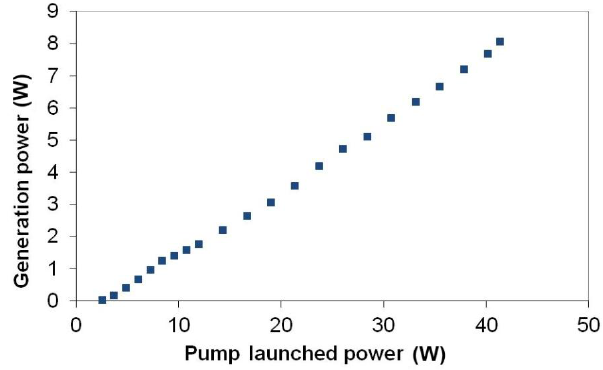
Figure 10. Output power versus launched power for experimental fiber laser.